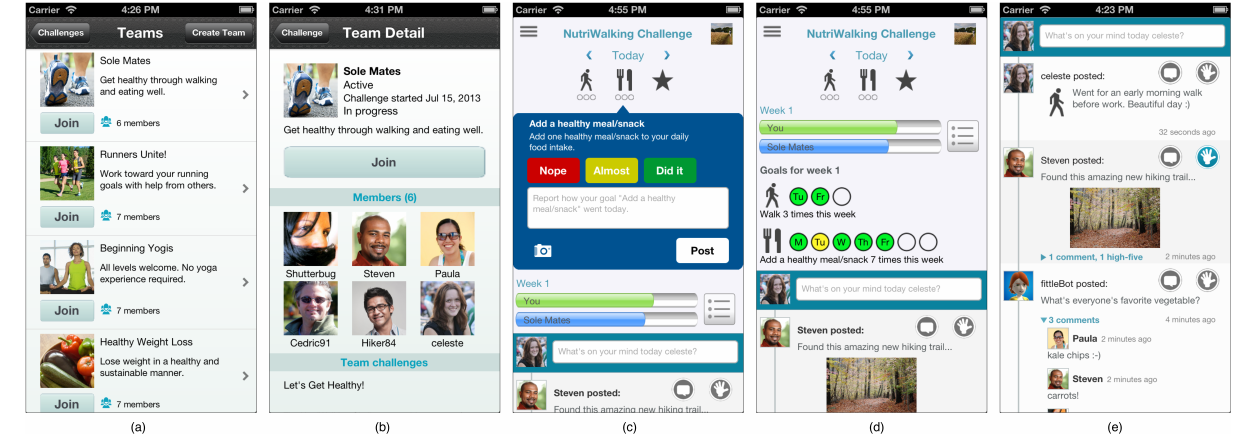
Figure 1. Fittle mobile application screens: (a) teams available, (b) the details of a team, (c) activity information, (d) overall goals for this week, and (e) the team-based social activity